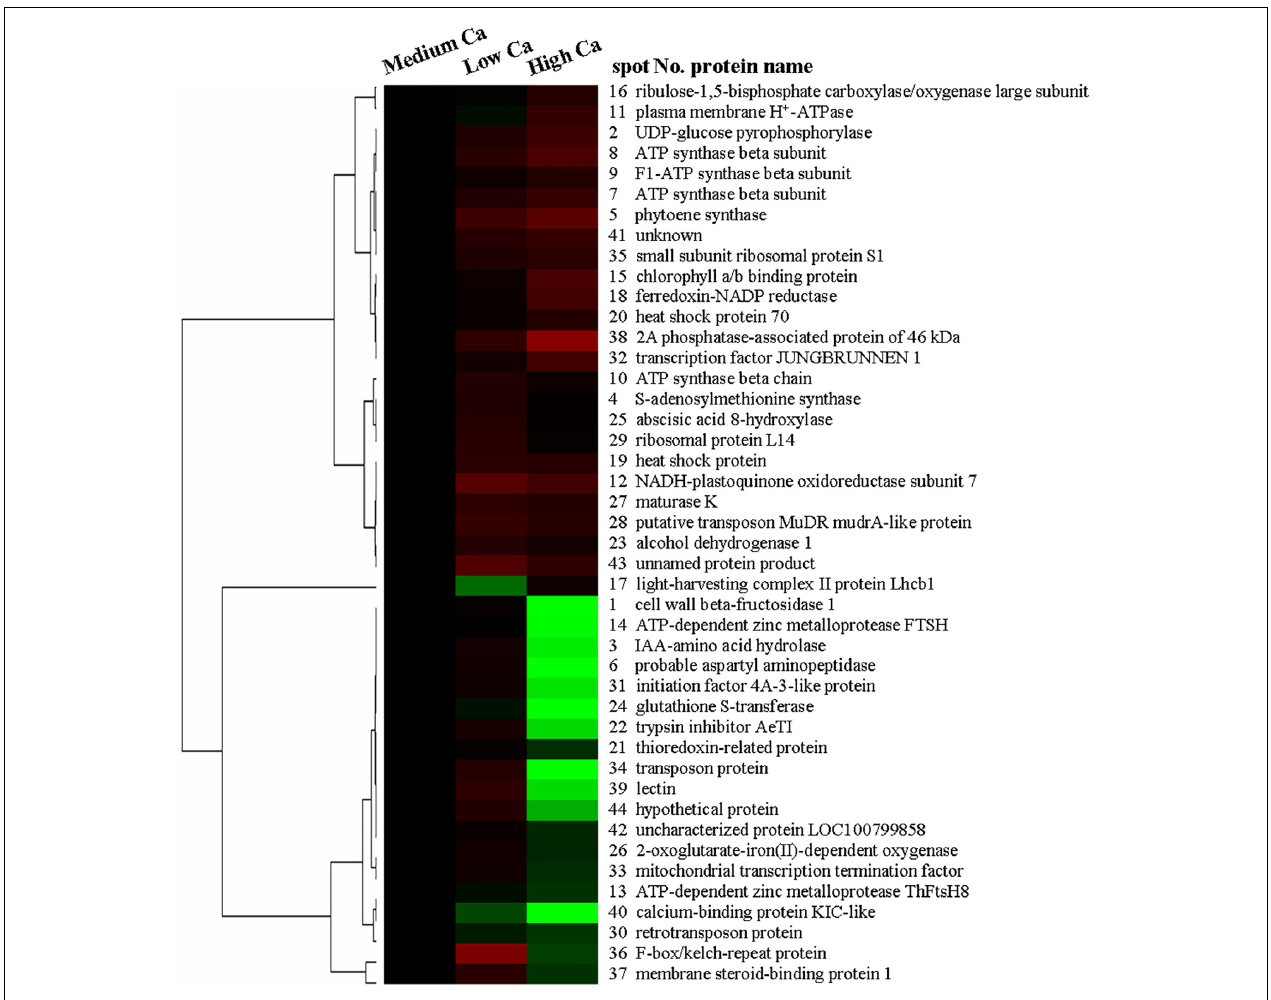
FIGURE 5 | Hierarchical clustering analyses of the 44 AR-responsive proteins expression profiles at different Ca levels in T. wallichiana var.